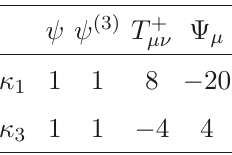
(5 a 3 c), E = 4 (a + 3c), and C 3 = SUSY 9 27 −